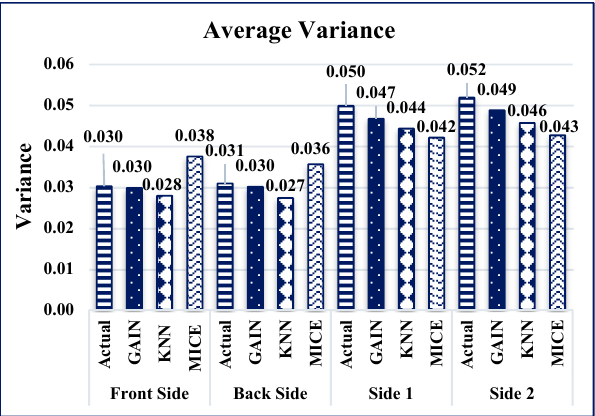
Figure 18. Average variance comparison.